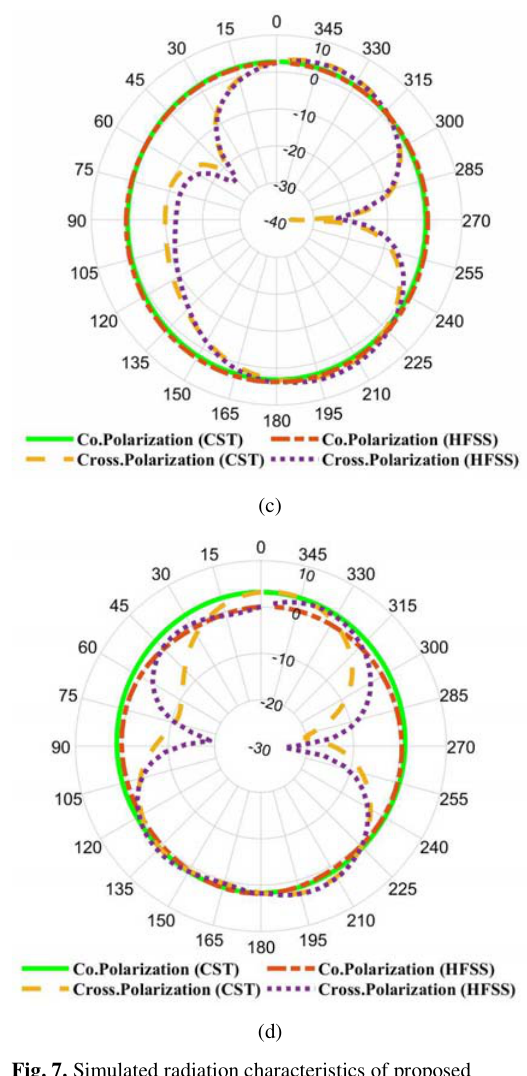
Fig. 7. Simulated radiation characteristics of proposed flower-shaped antenna (a) 3D at 11.8 GHz, (b) 3D at 15 GHz, (c) 2D at 11.8, (d) 2D at 15 GHz.